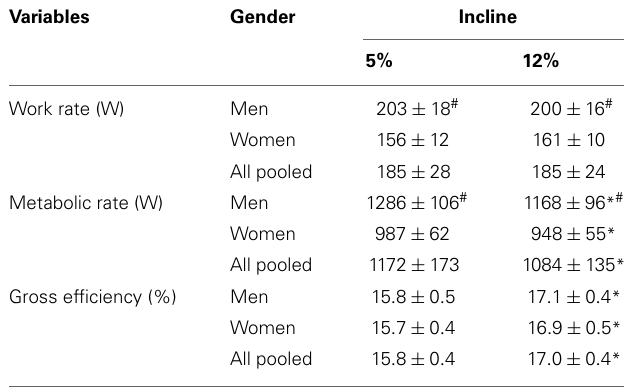
Table 3 | Work rate, metabolic rate and gross efficiency in 31 males and 19 females elite cross-country skiers while roller ski skating on a 5 and 12% inclined treadmill in the G3 and G2 skating technique respectively at similar work rates (mean ±